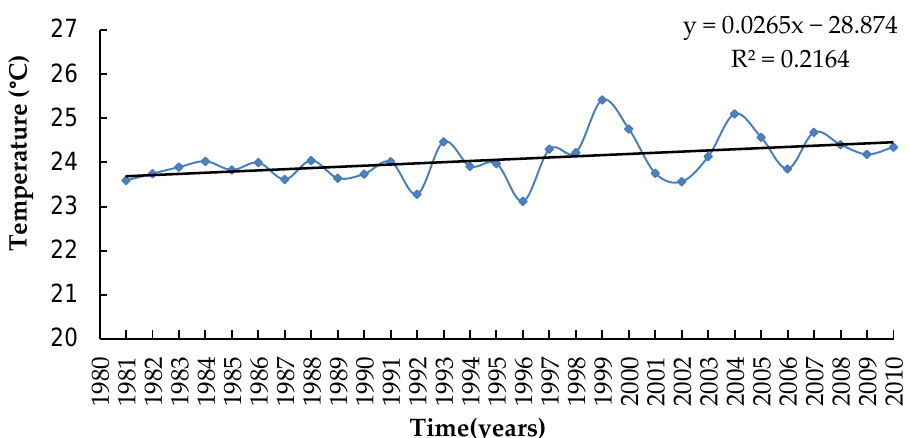
Figure 2. Observed average daily maximum temperature (May–August) for Ceres for the period 1981–2010.